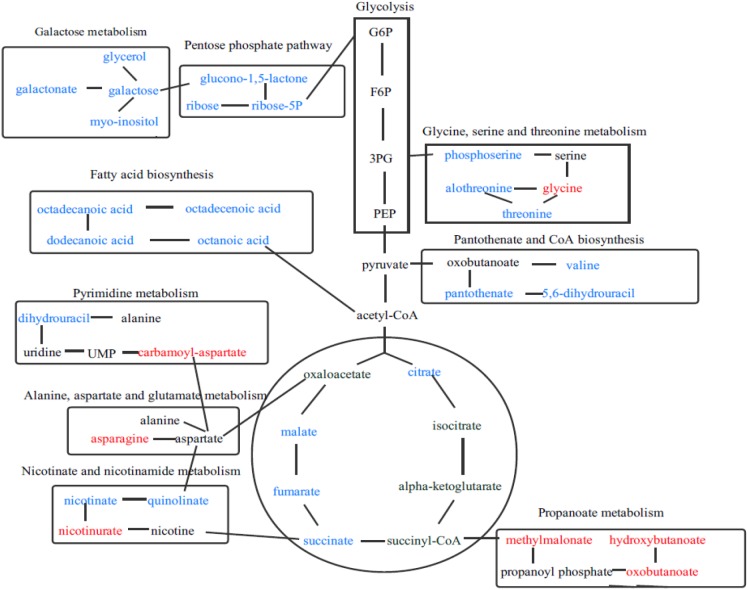
The relationship among some significantly changed pathways and differential metabolites involved in each metabolic pathway. Metabolites in red indicate lower concentration, while metabolites in blue show enhanced levels.